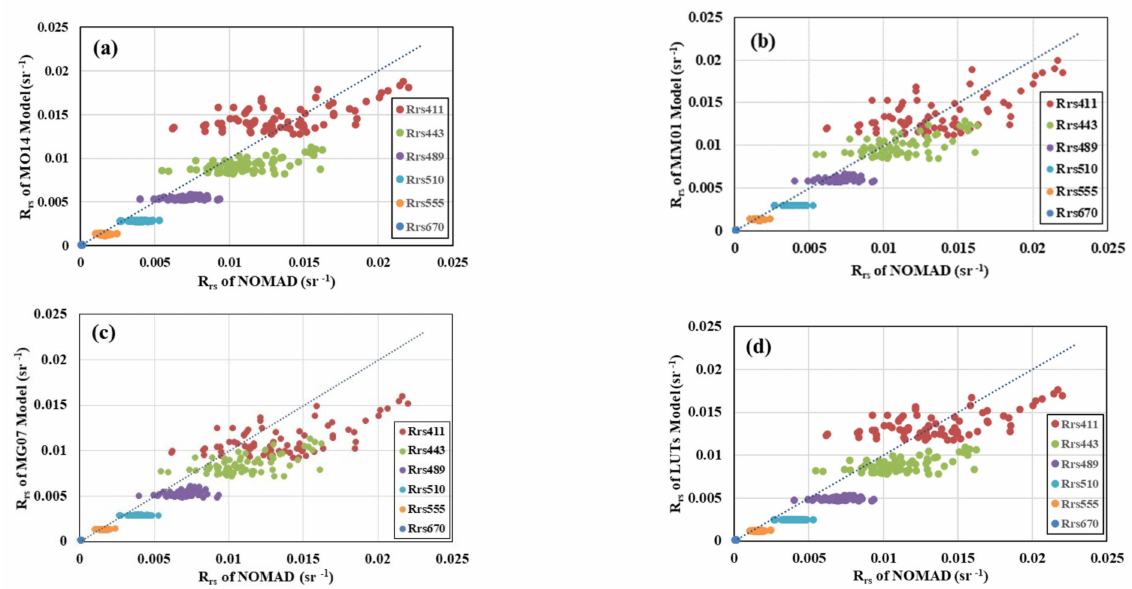
Figure A1. Performance of MM01, MG07, MO14, and LUTs models in oligotrophic ocean (( a ) MO14, ( b ) MM01, ( c ) MG07, ( d )